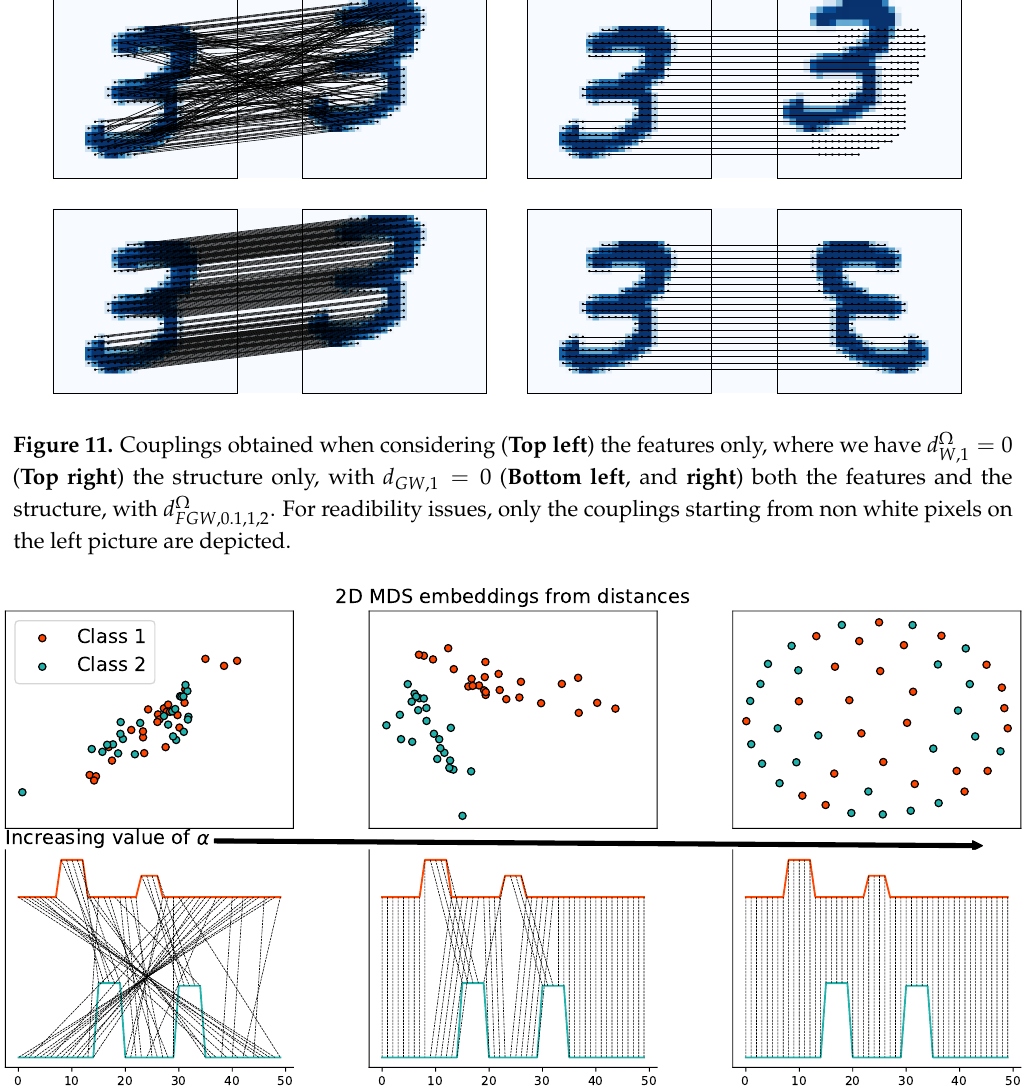
Figure 12. Behavior of trade-off parameter α on a toy time series classification problem. α is increasing from left ( α = 0: Wasserstein distance) to right ( α = 1: Gromov–Wasserstein distance). ( top row ) Two-dimensional (2D)-embedding is computed from the set of pairwise distances between samples with multidimensional scaling (MDS) ( bottom row ) illustration of couplings between two sample time series from opposite